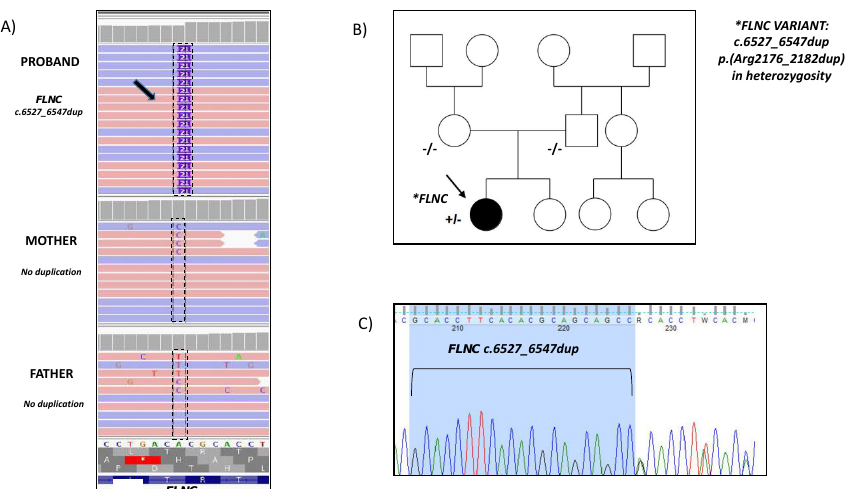
Figure 2. Pedigree and mutation analysis of the family. ( A ) Visualization by IGV software of NGS data (through alignment of enriched sequences to Hg 19) shows a 21-base pair duplication (purple) in the FLNC gene. ( B ) The proband (arrow) carried the variant c.6527_6547dup p. (Arg2176_2182dup) in heterozygosity in the FLNC gene. The variant was not found in the parents, resulting de novo. ( C ) The variant detected in the proband by NGS have been confirmed by Sanger